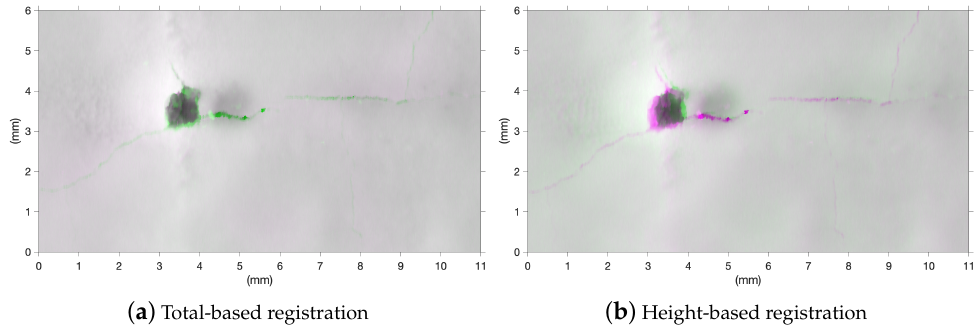
Figure 10. Result of the spatial registration of the surfaces (before/after treatment), shown as false color composite image of the two registered heights maps. ( a ) Registration performed on the Total intensity dataset and then applied to the height dataset. ( b ) Registration performed on the heights dataset. The root mean square error (RMSE) is 18µm and 26µm for the Total-based and the height- based registration respectively. The displacement in the crack feature in the height-based results is about 140µm.